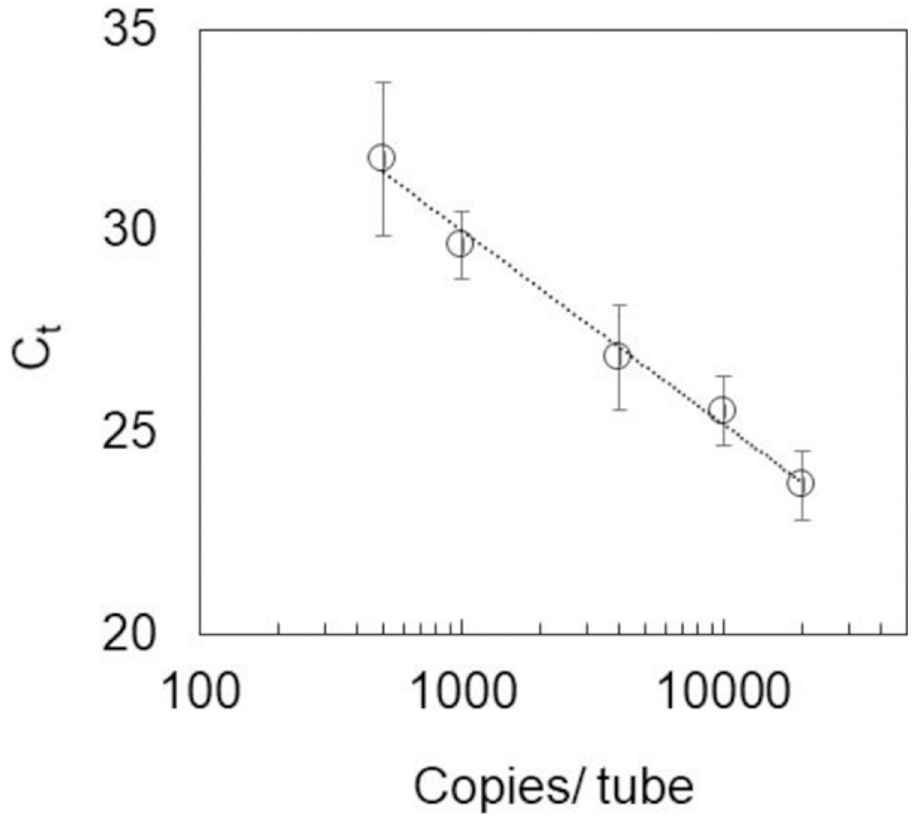
Fig 2. Calibration curve for RNA (preparation amount: 500, 1,000, 4,000, 10,000, 20,000 copies/tube).